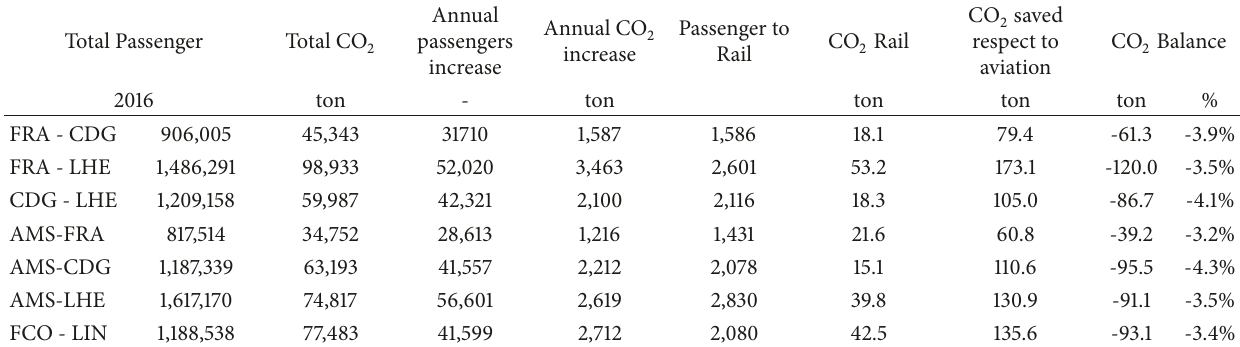
Table 10: Low-rail scenario with 3.5% annual growth and 5% shifting between the modes.